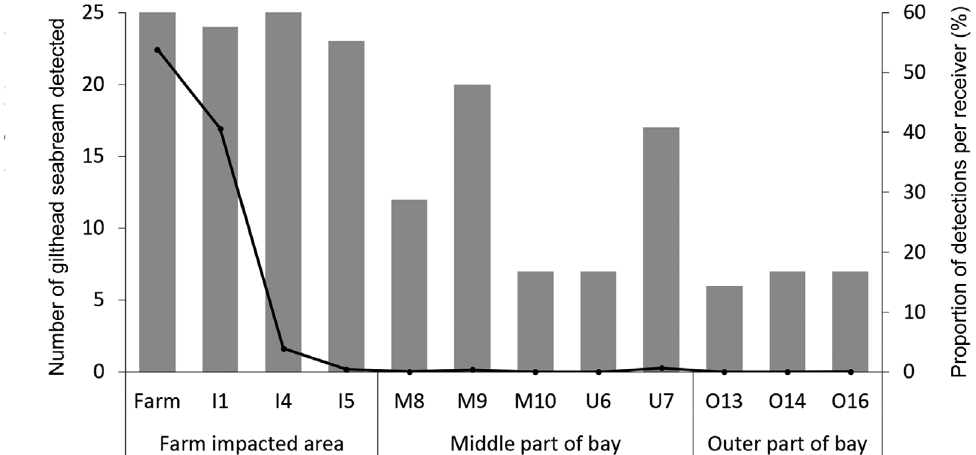
Fig. 3. Spatial distribution of acoustically tagged Sparus aurata within the bay during the total study period (12 wk). Plotted line shows proportion of overall detections for each receiver. No fish were detected at receivers M11, O12 and